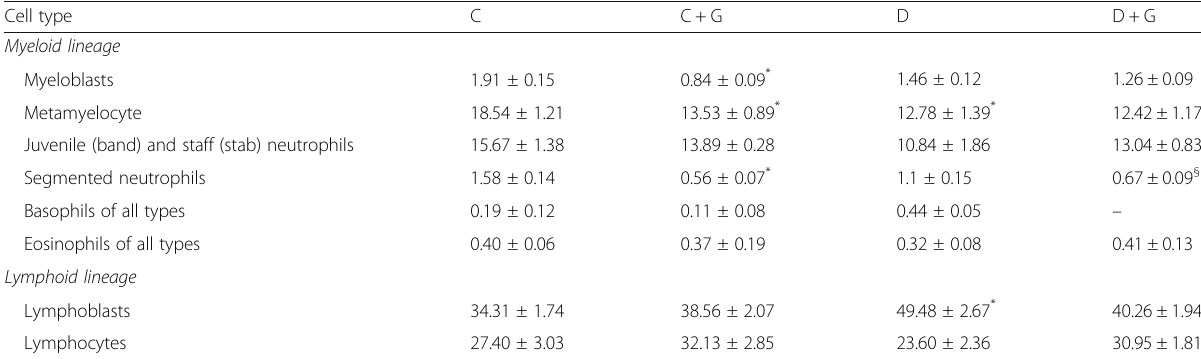
Table 2 The ratio (in %) of neutrophils and lymphocytes precursors in the bone marrow of control animals, animals with diabetes mellitus and under the condition of Galega officinalis extract administration